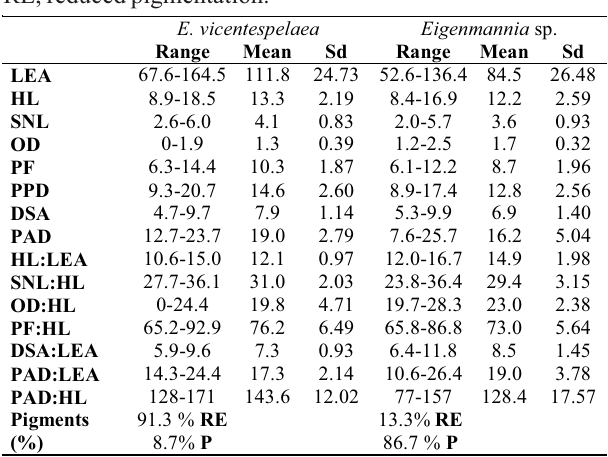
Table 1 . Morphometric data for the cave knifefish, E. vicentespelaea (n = 23) and epigean knifefish, Eigenmannia sp. (n=15), from São Domingos karst area, Goiás State, Cen- tral Brazil. Measurements expressed in mm and proportions in percentage. Sd, standard deviation; P, pigmented individual; RE, reduced pigmentation.